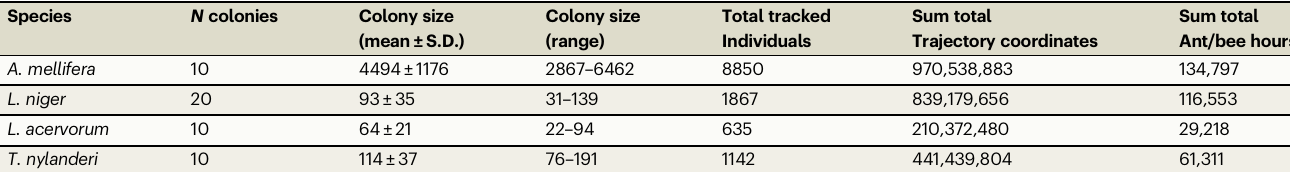
Table 1 | Summary statistics for colony sizes and tracking data